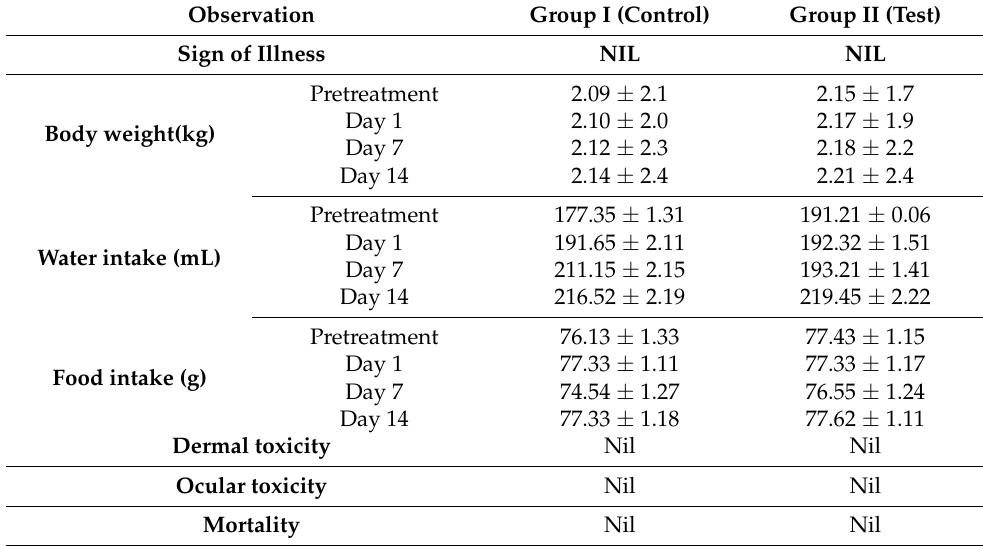
Table 5. Clinical findings during acute oral toxicity studies.